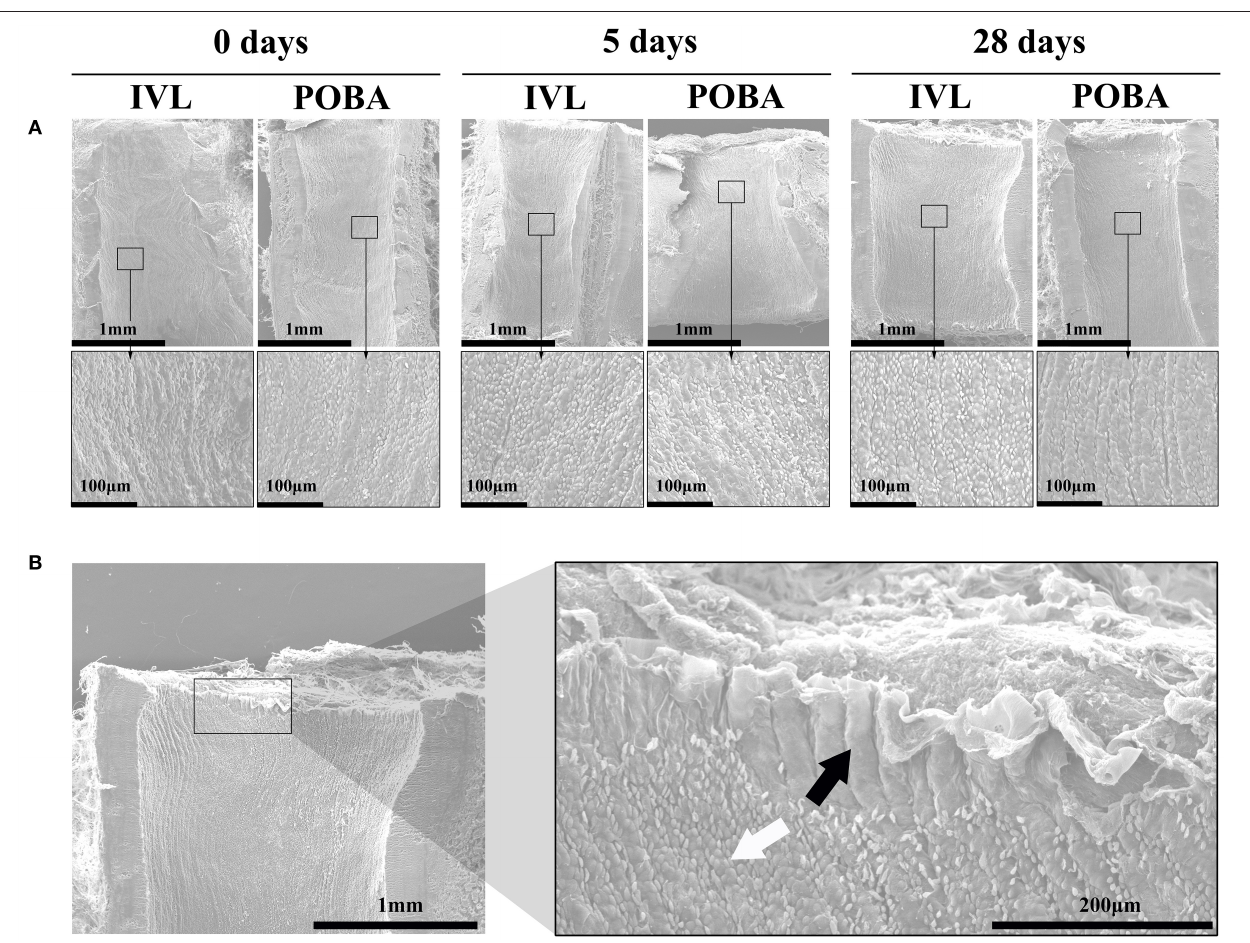
FIGURE 4 | Representative luminal surface SEM images. (A) SEM images of the IVL and POBA groups at 0, 5, and 28 days postoperatively. Magnified images of rectangular areas are shown below each low-magnification image. The lumens of both groups were covered by flattened and cobblestone-shaped endothelial cells with a wave-like arrangement. (B) The internal elastic lamina (black arrow) was the structural basis of this wave-like arrangement of endothelial cells (white arrow). SEM, scanning electron microscopy; IVL, intravascular lithotripsy; POBA, plain old balloon